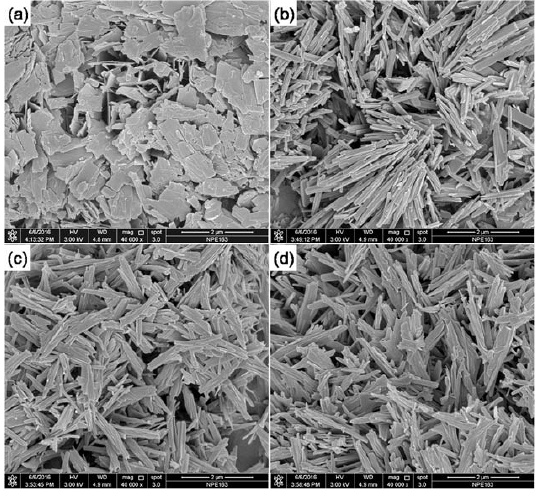
Figure 2. SEM images of the products under various conditions: ( a ) V:C = 1:1.25, 48 h; ( b ) V:C = 1:1.75, 48 h; ( c ) V:C = 1:1.75, 6 h; ( d ) V:C = 1:1.75, 12 h. (at 180 °C).